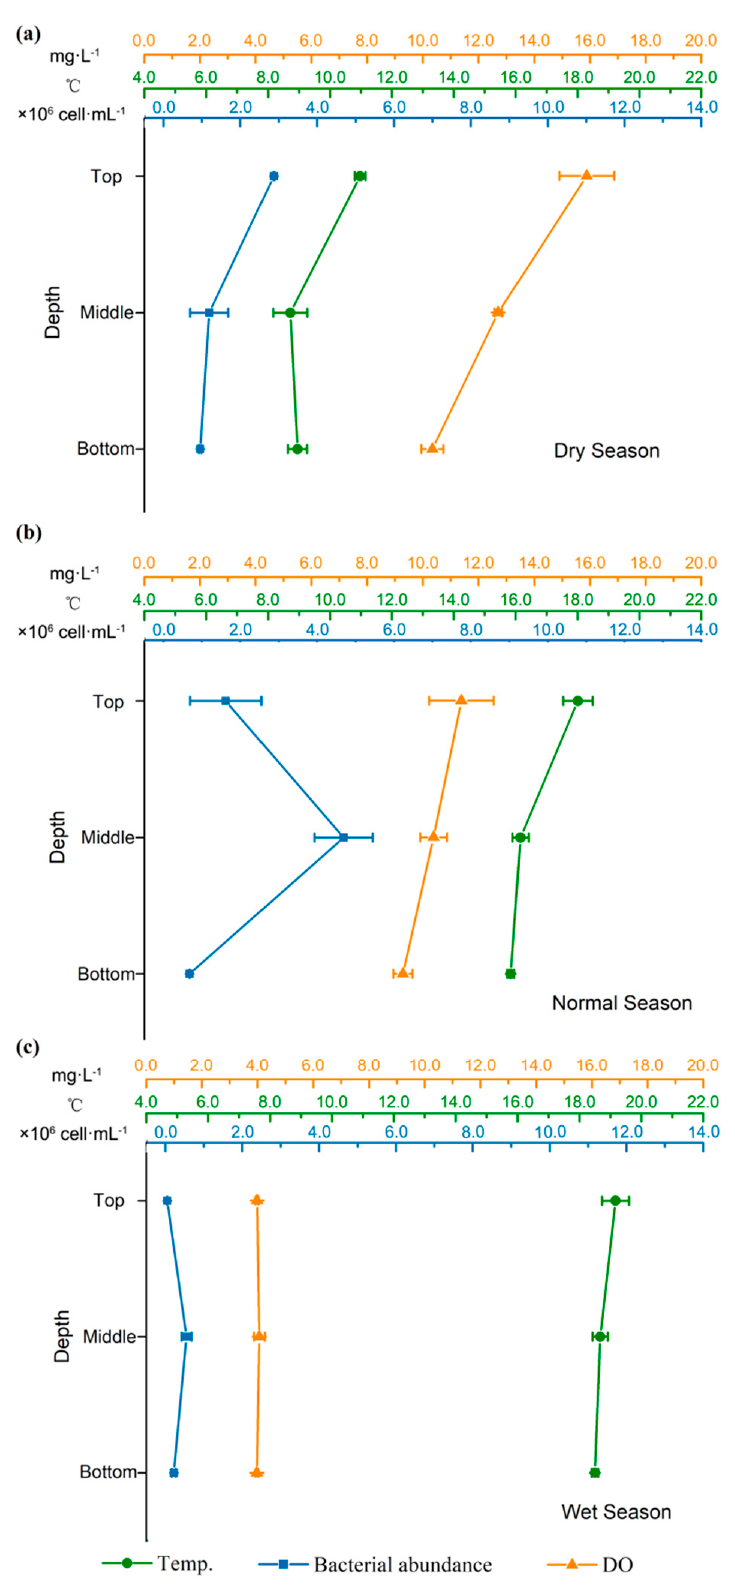
Figure 2. Vertical profile of water temperature, dissolved oxygen concentrations, and bacterial abundance at the Gongguoqiao Reservoir (S1) in dry ( a ), normal ( b ), and wet ( c ) seasons. Percentages of OM measured in sediment varied significantly ( p < 0.05) from S1 to S4 over three seasons. Because of enhanced precipitation and discharged occurring in normal and wet seasons, significantly lower microbial activities were recorded than in the dry season. 3.1.2. Changes of TN Concentrations For the seasonal sampling periods, there was a significant difference for TN (Table 3). The TN content of surface water at all sampling sites was 3.6 to 6 times greater in the dry season compared with that in the wet season. Low values in the rainy season are directly related to the influence of strong precipitation. In the reservoir (i.e., S1) (see Table S5 in Supplemental Materials), the TN